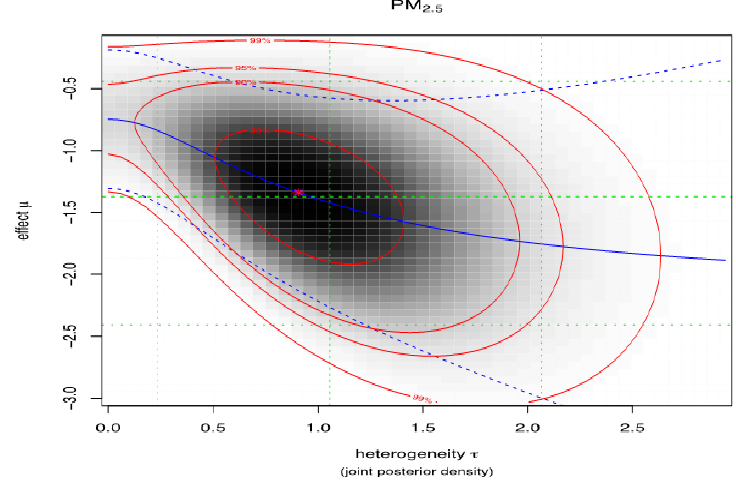
Figure 6. Heterogeneity plot PM 2.5.